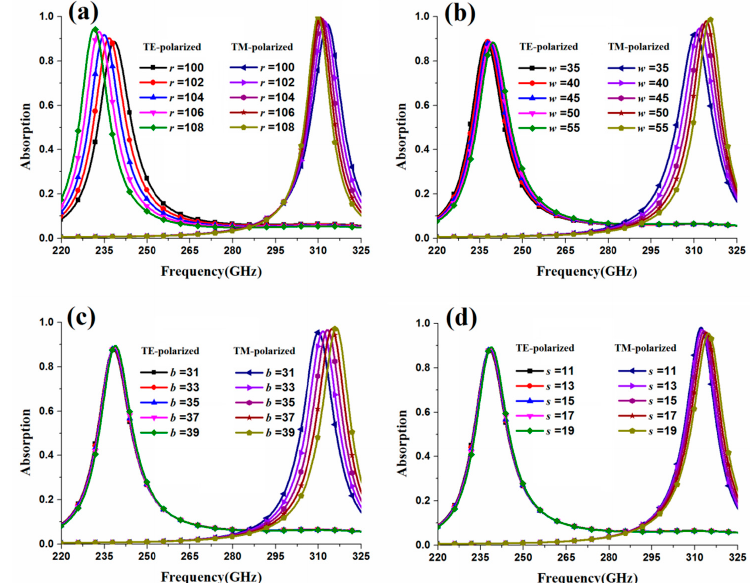
Figure 6. Simulated absorption spectrum dependence on different structural parameters: ( a ) the inner radius of ring, r, ( b ) the width of vertical connecting bar, w, ( c ) the width of the horizontal bar, b, and ( d ) the gap between the horizontal bar and the edge of the unit cell, s.